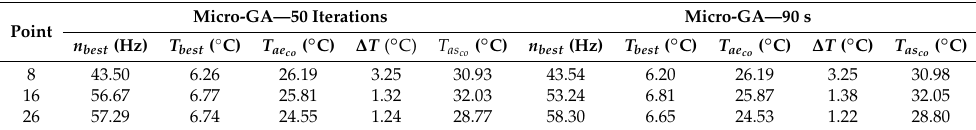
Table 9. Verification of compliance of Micro-GA with the operational restrictions of the equipment for the 3 operational